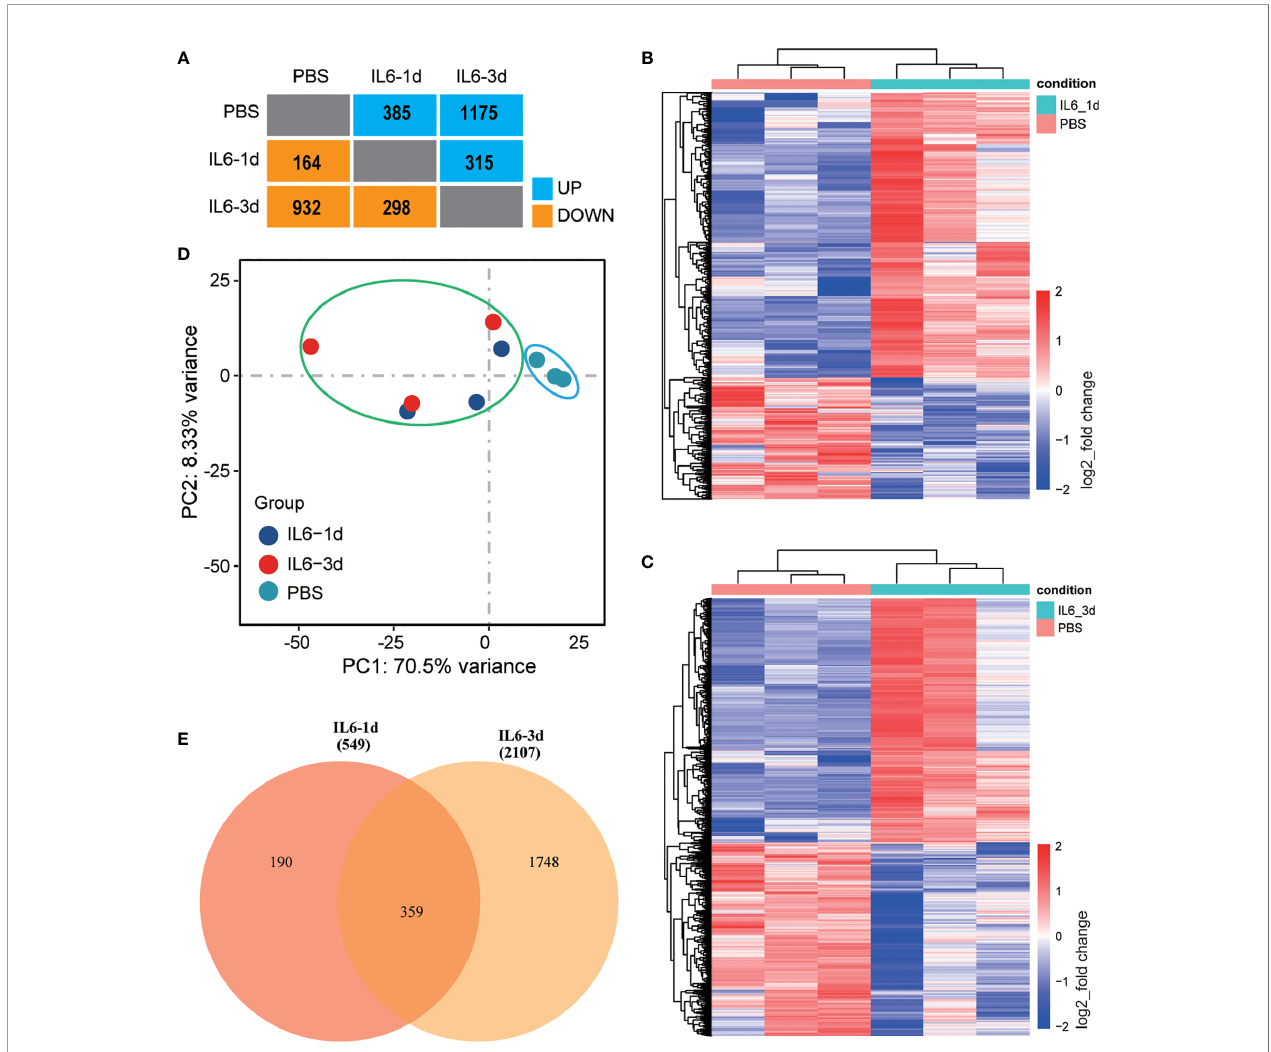
FIGURE 2 | Identi fi cation of differentially expressed genes (DEGs) in skeletal muscle after interleukin-6 (IL-6) infusion. (A) A summary of the number of DEGs after one and three days of IL-6 infusion in the intervention group compared with the control group. Blue indicates up-regulated genes, and orange indicates down- regulated genes. (B, C) Heat maps of all differentially expressed genes after one day (B) and three days (C) of IL-6 infusion. Red indicates up-regulated expression, and blue indicates down-regulated expression. (D) Principal component analysis of a single-sequencing sample. The shorter the sample clustering distance, the more similar the samples. The control group is marked by a blue ellipse and the experimental group by a green ellipse. (E) VENNY diagram of the overlap of DEGs after one and three days of IL-6 infusion. IL-6, interleukin-6; PBS, phosphate-buffered